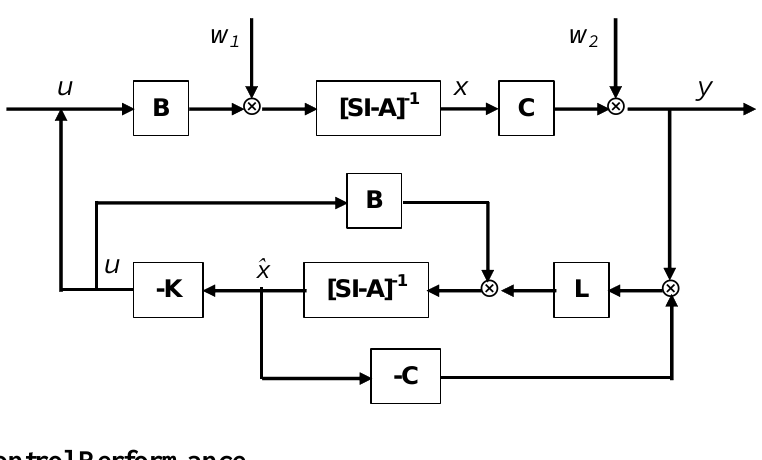
Figure 2. Block diagram of LQG control algorithm.